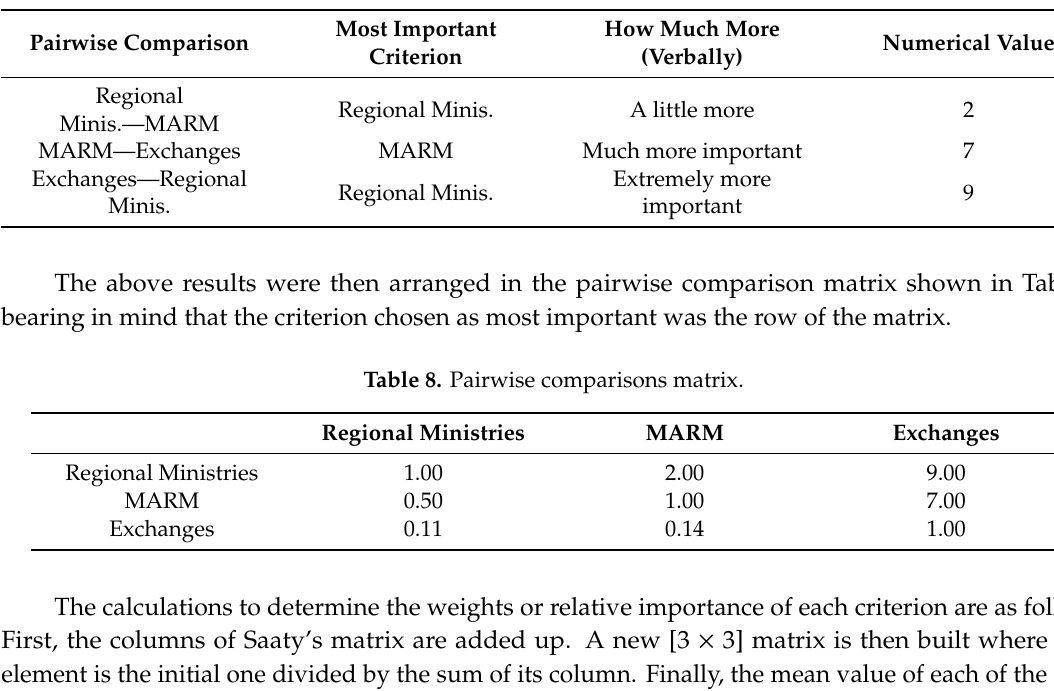
Table 7. Weighting of the information sources by the experts.